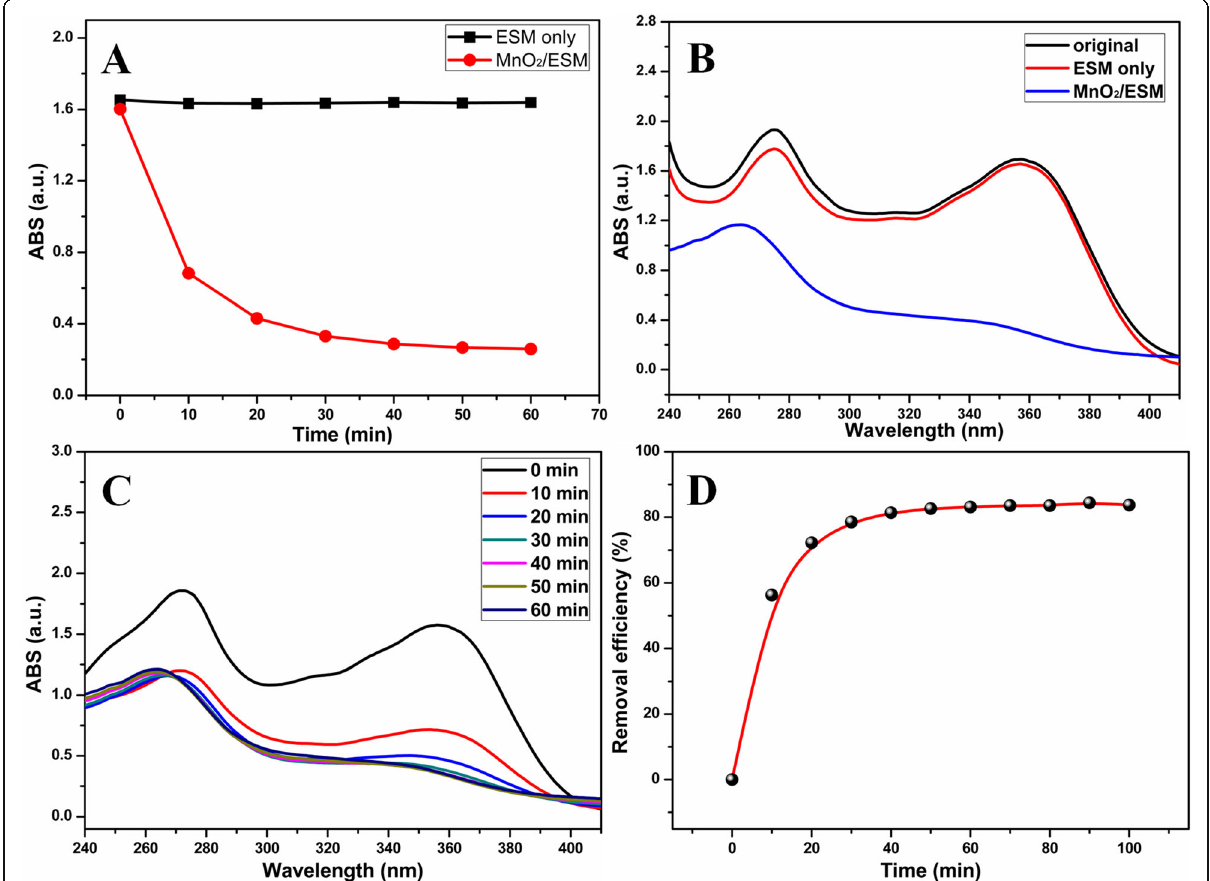
Fig. 4 a The time-dependent absorption intensity of TCH by ESM and MnO 2 NPs/ESM treatment. b The UV-vis absorption spectra of TCH before and after ESM or MnO 2 NPs/ESM treatment. c The time-dependent UV-vis absorption spectra of TCH and ( d ) removal efficiency treated by MnO 2 NPs/ESM. (Conditions: 20 slices of MnO 2 NPs/ESM or ESM, the initial concentration of TCH was 50 mg/L, controlled pH was